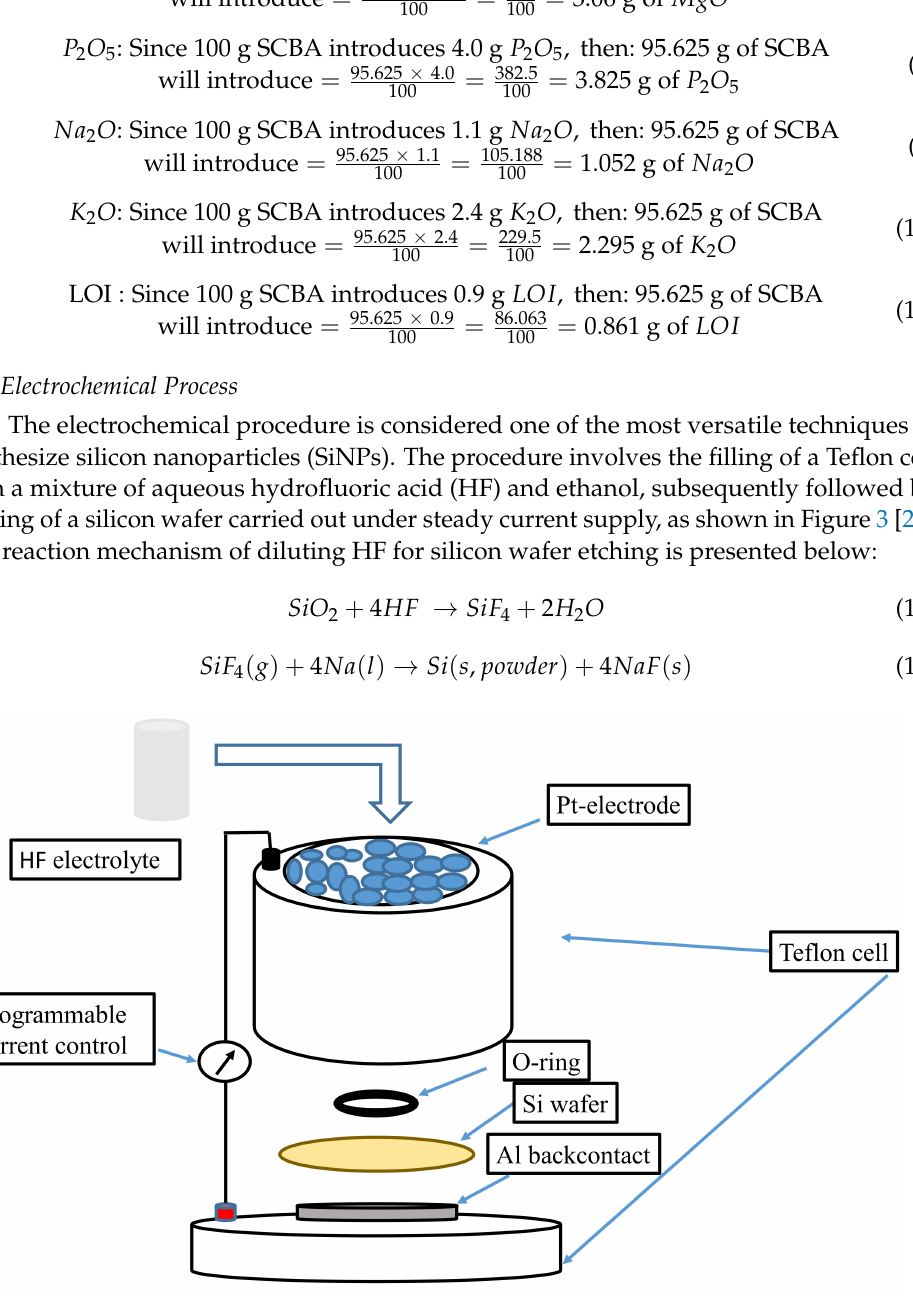
Figure 3. Electrochemical etching